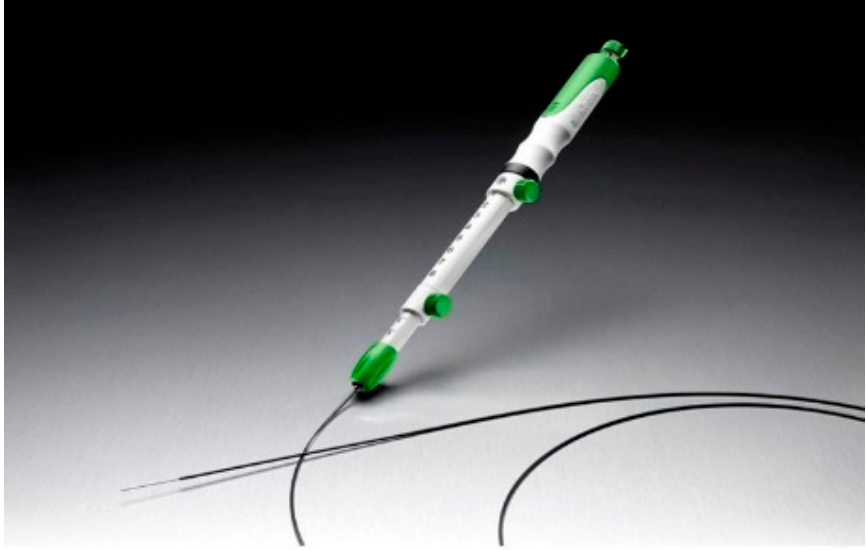
Figure 3. The Sono Tip Topgain ® (MediGlobe, Rohrdorf, Germany).